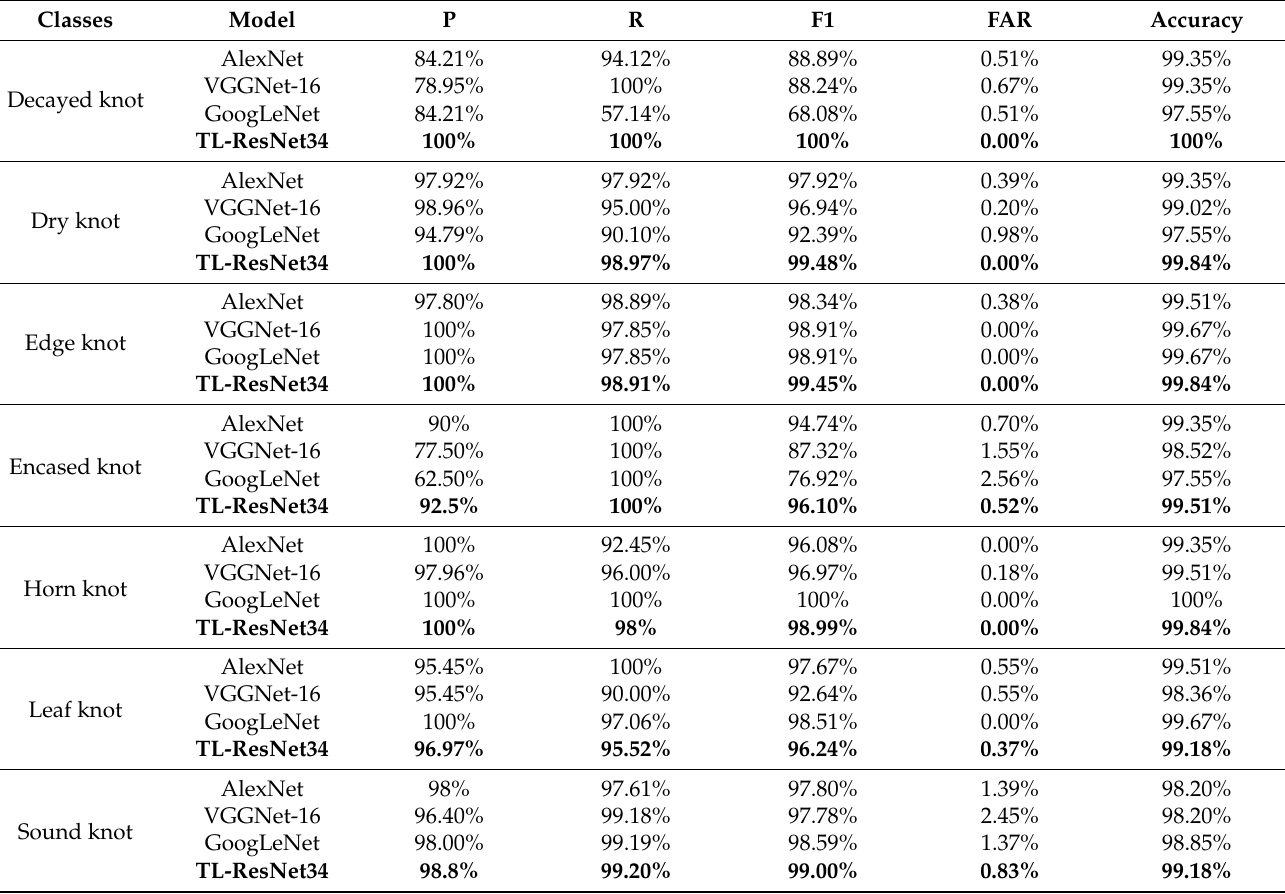
Table 5. The evaluation index values of the